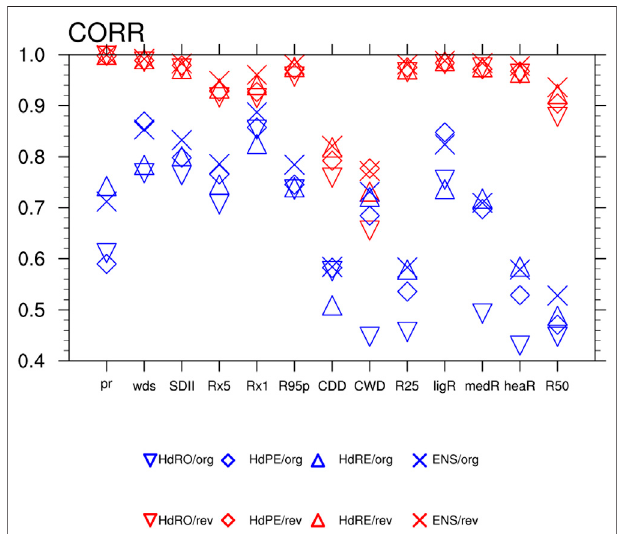
FIGURE 8 | Correlation coef fi cients of 13 precipitation indexes before andaftercorrection.Theletters “ rev ” indicatestherevisedsimulations,andthe letters “ org ” denote the simulations before